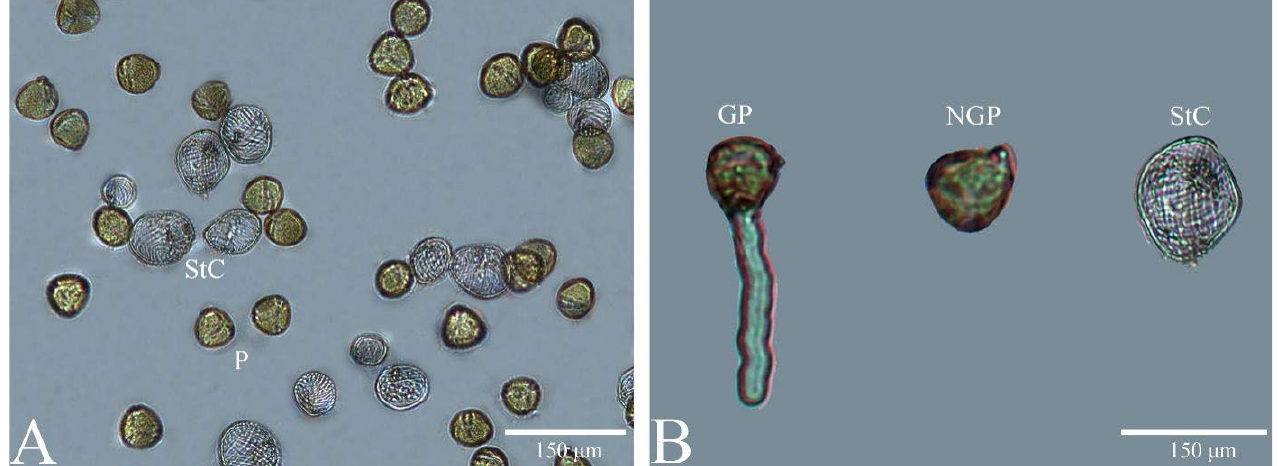
Figure 5. In vitro germination of pollen and stomium cells in Camellia oleifera . ( A ): a large number of stomium cells mixed with pollen when the medium was first sprinkled with pollen. ( B ): two hours after sprouting, pollen partially germinated, while no sign of germination was found in stomium cells. P, pollen; GP, germinated pollen; NGP, non-germinated pollen; and StC, stomium cells.